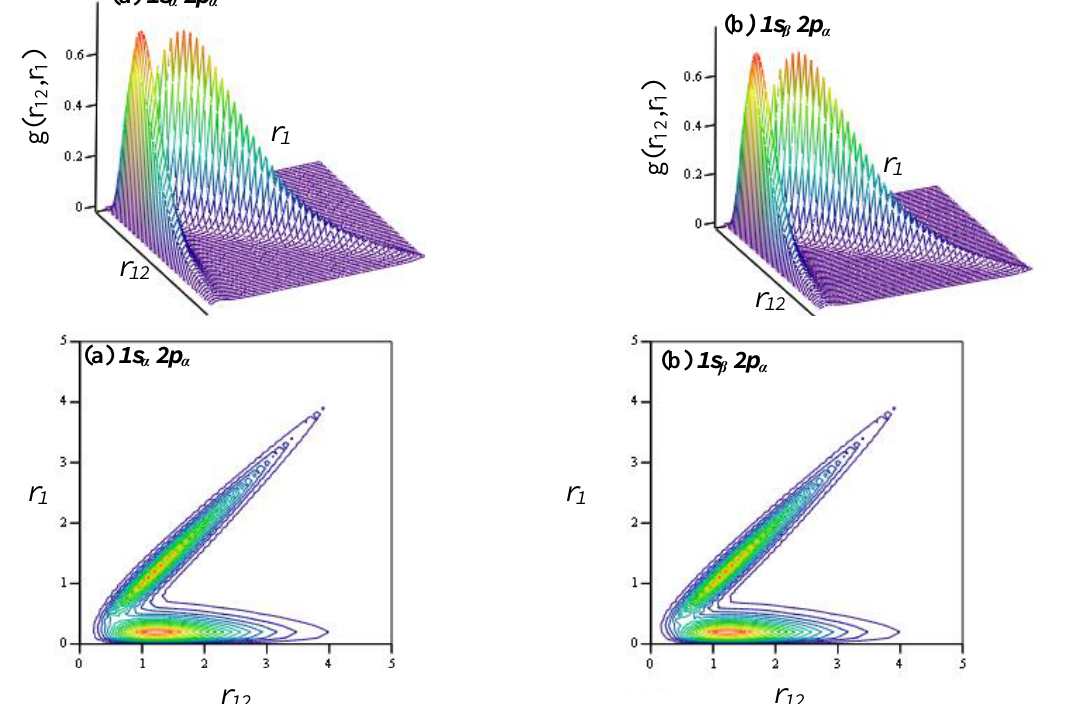
Fig. 8: The surfaces and contours of the partial distribution function